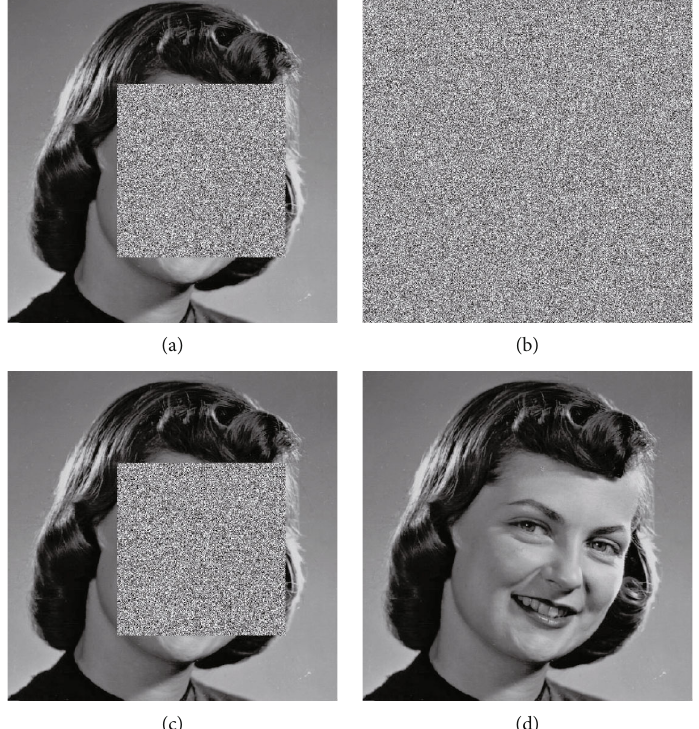
Figure 6: Visualization for girl. (a) First encryption. (b) Second encryption. (c) Decrypt for the fi rst time. (d) Decrypt for the second time.